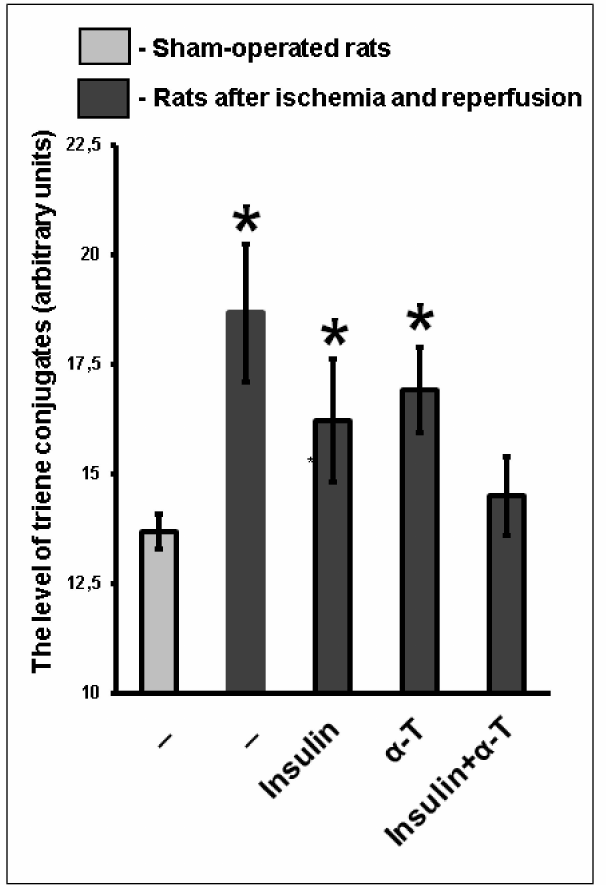
Figure 10. The effect of intranasally administered insulin and orally administered α -T on the level of conjugated trienes in the brain cortex of rats with two-vessel forebrain ischemia followed by reperfusion. The data of 5–7 experiments are presented as the means ± SEM. The two-vessel forebrain ischemia was induced by ligation of carotid arteries for 20 min and hypotension followed by reperfusion for 1 h. Insulin was administered intranasally at a dose of 0.25 IU/rat, while α -T was given orally at a dose of 50 mg/kg. *—The differences are significant according to Student’s t -test as compared to control values in the brain cortex of sham-operated rats, p <